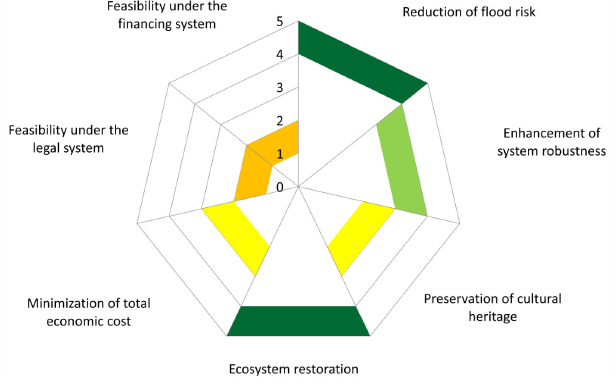
Fig. 7 . Radar diagram of the effects of the resilient strategy, when compared with the resistant strategy. The scoring is as follows: 5 (strong positive effect), 4 (positive effect), 3 (neutral), 2 (negative effect), and 1 (strong negative